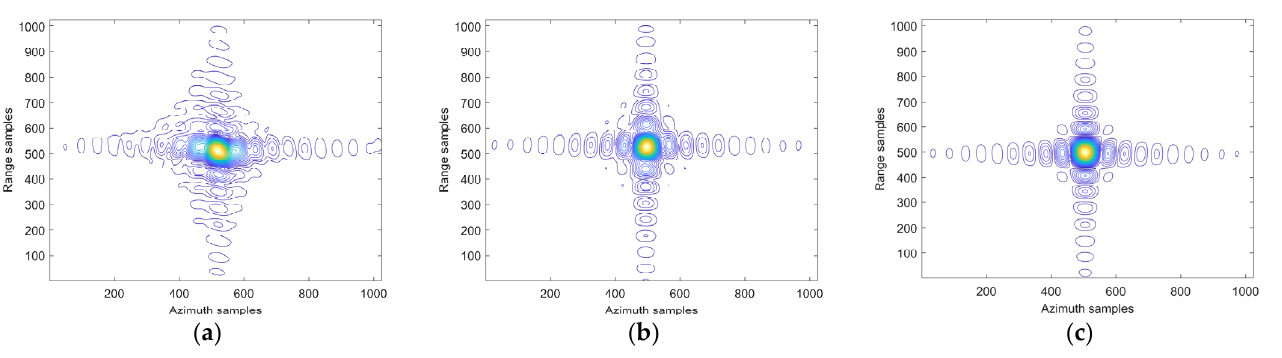
Figure 18. Contour plot of target P5 processed by di ff erent algorithms. ( a ) The conventional method; ( b ) The reference method; and ( c ) The proposed method.